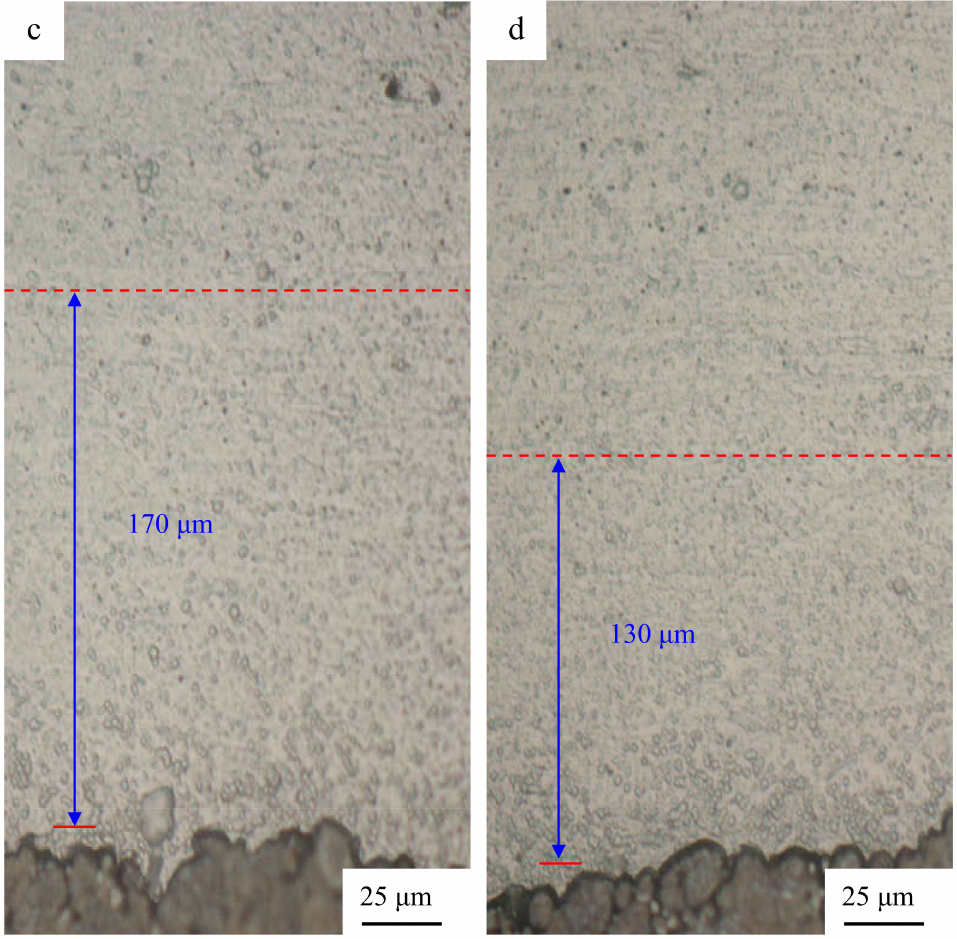
Figure 7. Optical microscope (OM) images of the Al side for Al/Al joints with interlayers of different thicknesses: ( a ) without an interlayer; ( b ) 10 µ m; ( c ) 30 µ m, and ( d ) 60 µ